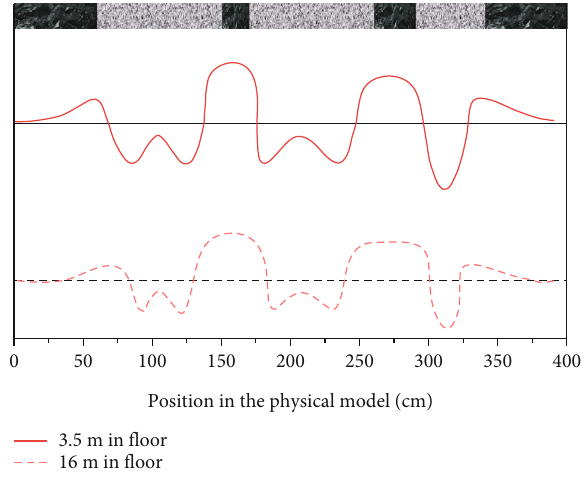
Figure 9: Typical bottom stress distribution curves for di ff erent depths after the 8-1 coal seam